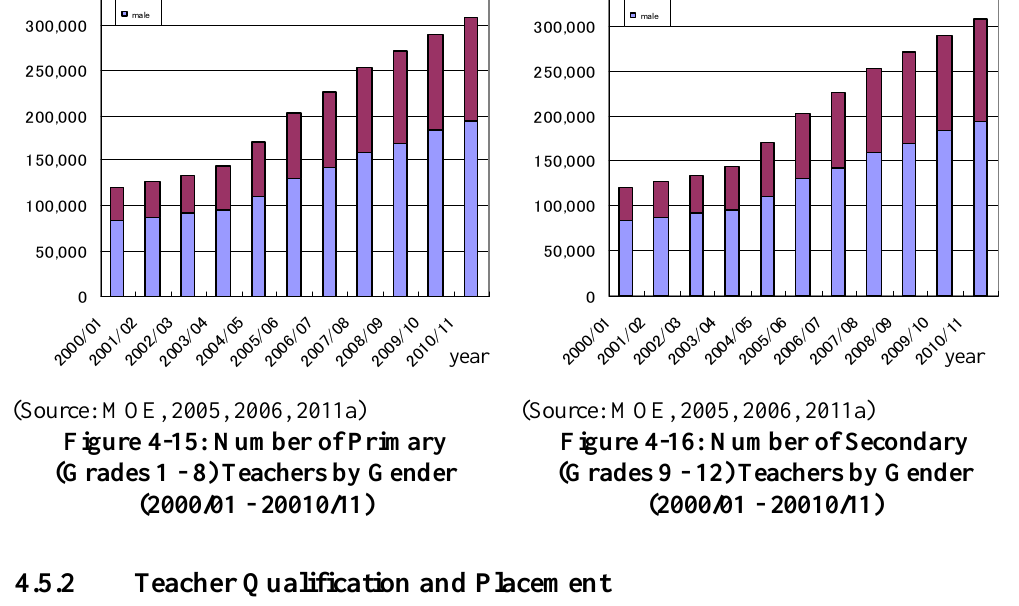
Figure 4-15: Number of Primary (Grades 1 - 8) Teachers by Gender (2000/01 - 20010/11)